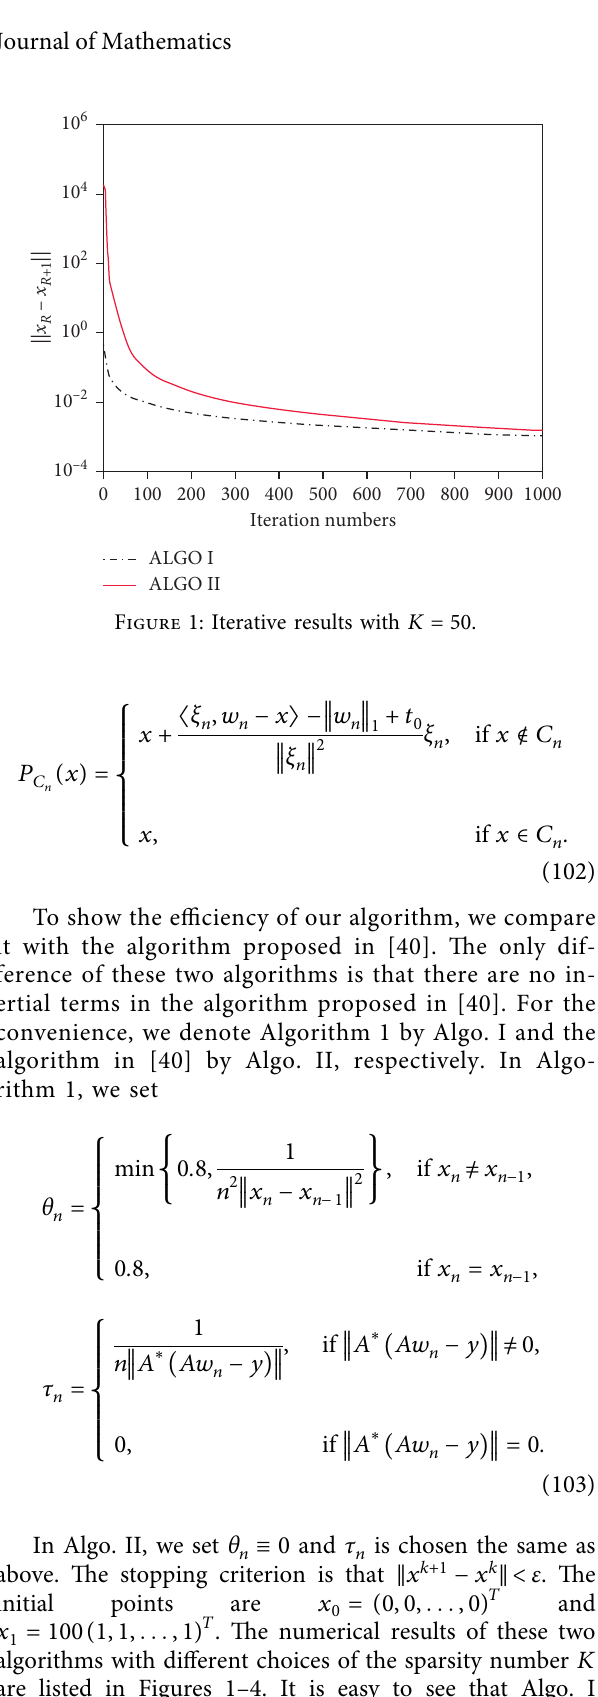
Figure 4: Iterative results with K �